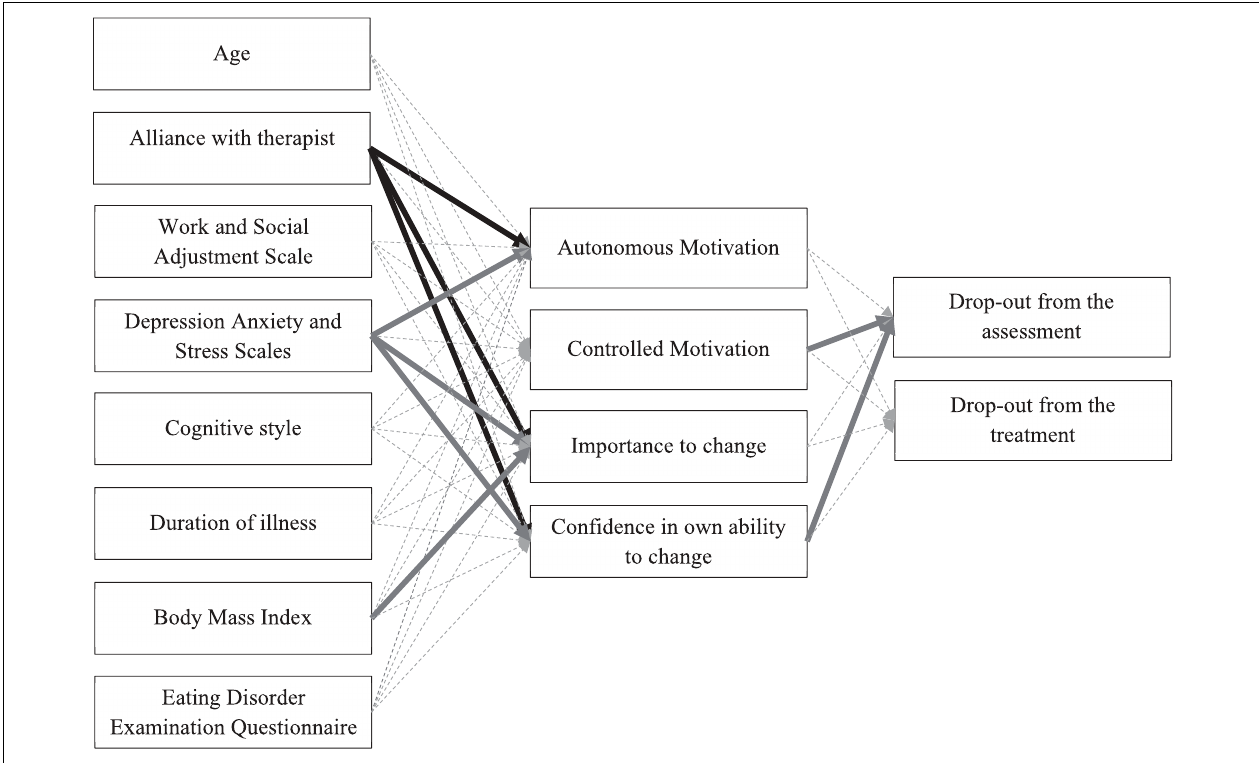
FIGURE 3 | Structural equation model. This model describes the relationships between patient demographic and clinical variables, self-reported motivation and drop-out from the 6 weeks assessments and Recovery MANTRA intervention. Errors are omitted from the diagram. Significant positive parameters are represented by black solid lines. Significant negative parameters are represented by gray solid lines. Non-significant parameters are represented by gray dashed lines. For clarity, correlations between variables are omitted from the diagram: autonomus motivation is not significantly correlated to controlled motivation ( p < 0.001), importance to change ( p < 0.01) and confidence in ability to change ( p < 0.01); moreover, importance to change is correlated to confidence in ability to change ( p < 0.01) and drop-out from the assessment is correlated to drop-out from the treatment ( p < 0.001).